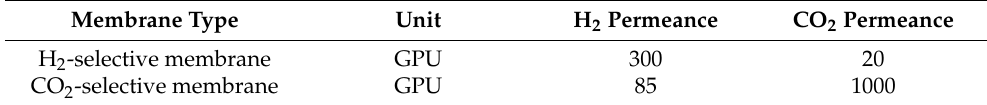
Table 2. Performance of commercial membrane